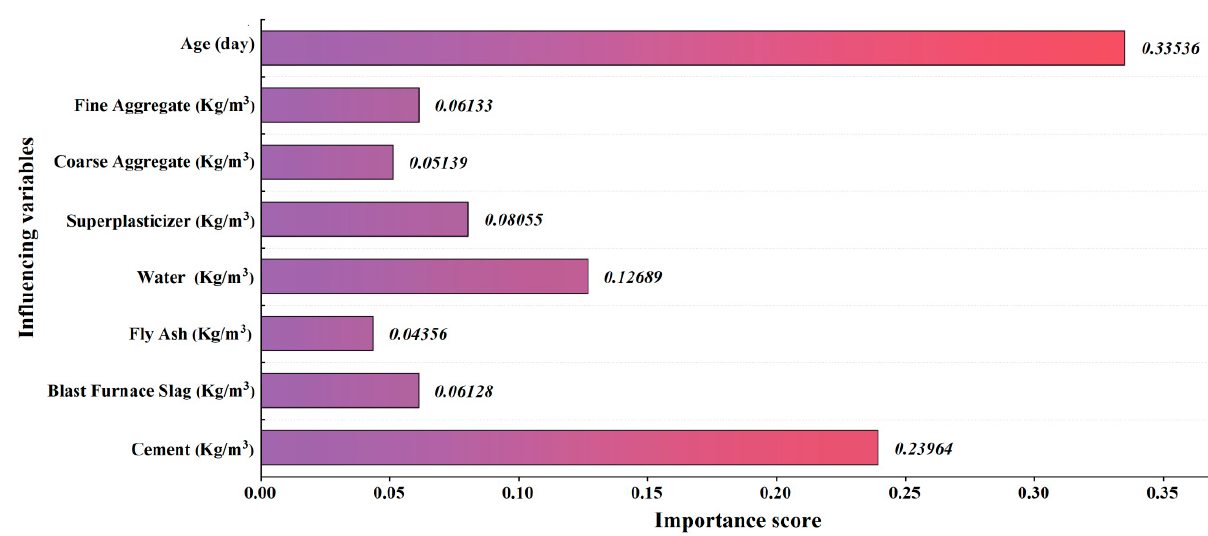
Figure 10. Sensitivity analysis of input variables.